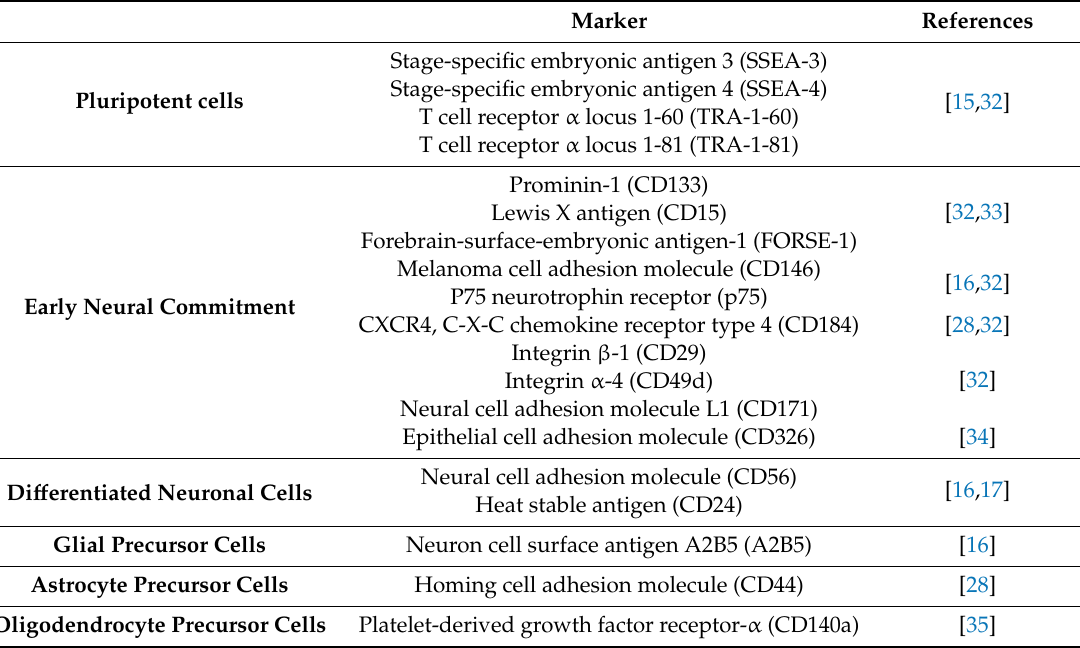
Table 2. Progressive expression of cell surface-specific markers. Di ff erent sets of genes can discriminate developmental stages as well as lineage specific commitment. After maturation, fate-restricted precursors can be identified by surface